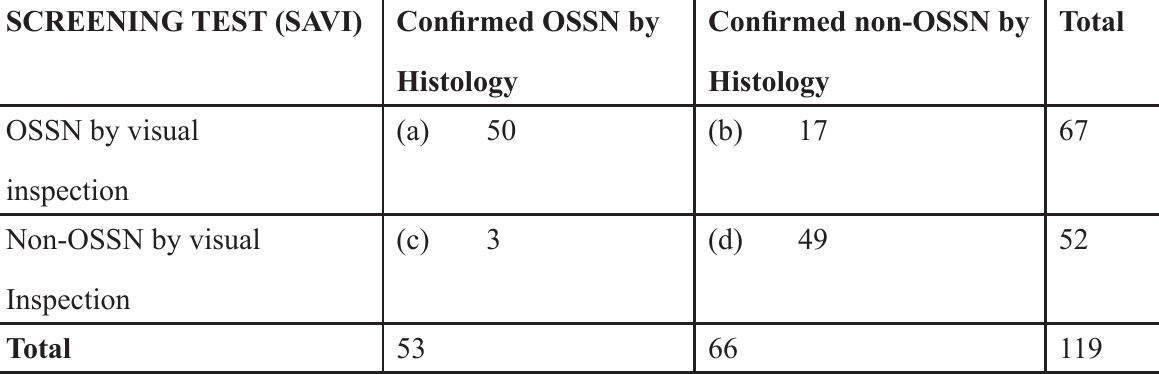
Table 1: Comparative analysis of OSSN results screened by SAVI against histology. SCREENING TEST (SAVI)